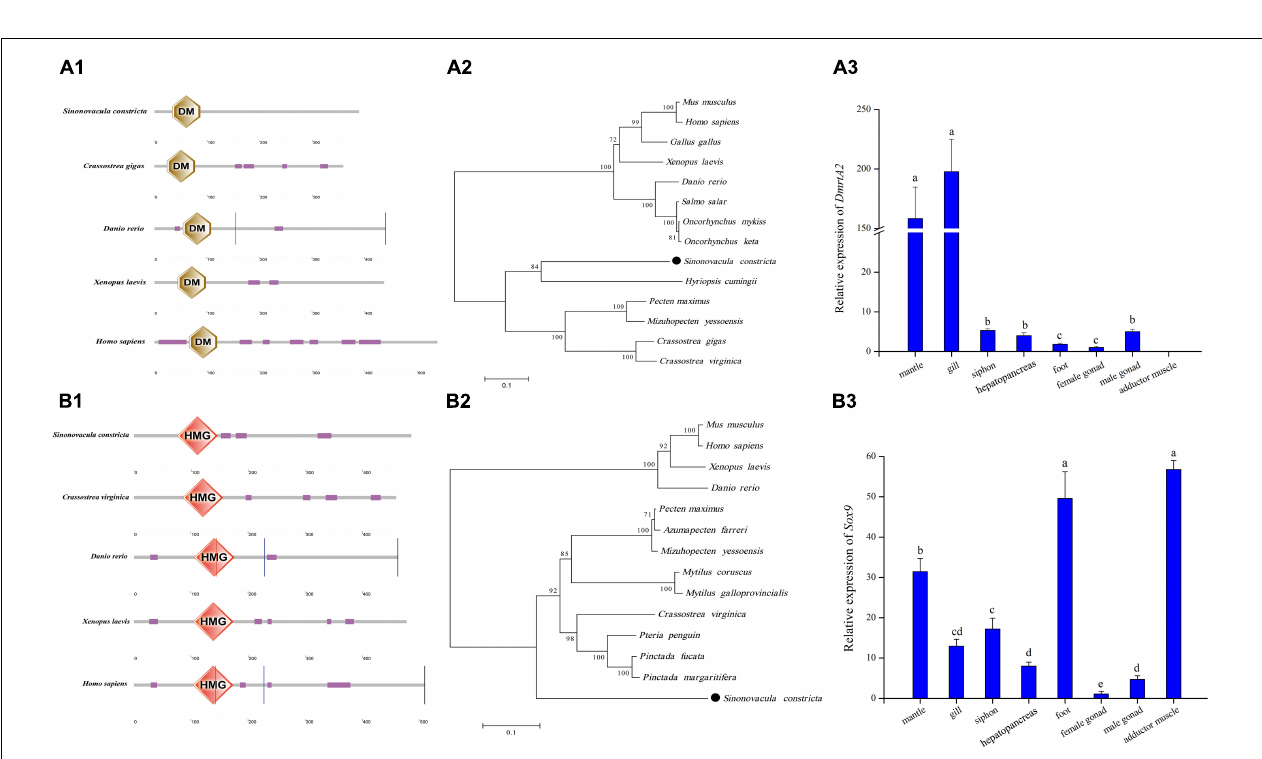
FIGURE 8 | Analysis of ScDmrtA2 and ScSox9 protein domains and their expression profile in adult tissues with standard deviation as error bars ( n = 3) in S. constricta . (A1) DmrtA2 domain structures of razor clam and selected model species. (A2) The phylogenetic tree generated with DmrtA2 proteins. (A3) Relative expression level of ScDmrtA2 in adult tissues. (B1) Sox9 domain analysis of razor clam and other model species. (B2) The phylogenetic tree generated using Sox9 proteins. (B3) Expression profile of ScSox9 in adult tissues.